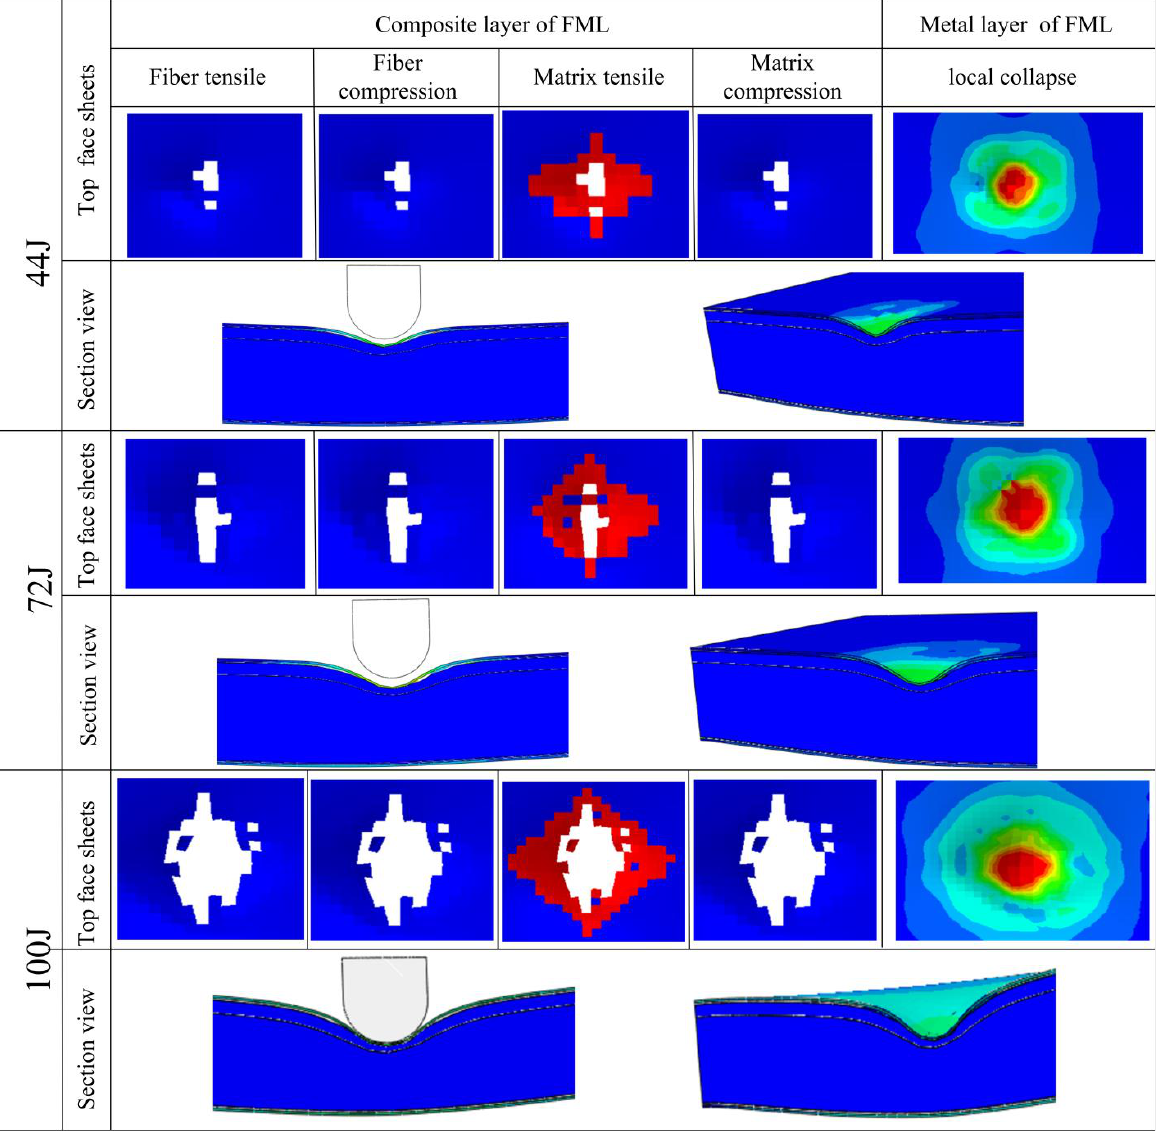
Figure 7. Failure morphologies of the BCSP with different impact energies.